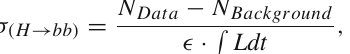
Table 5. The systematic uncertainties on the selection